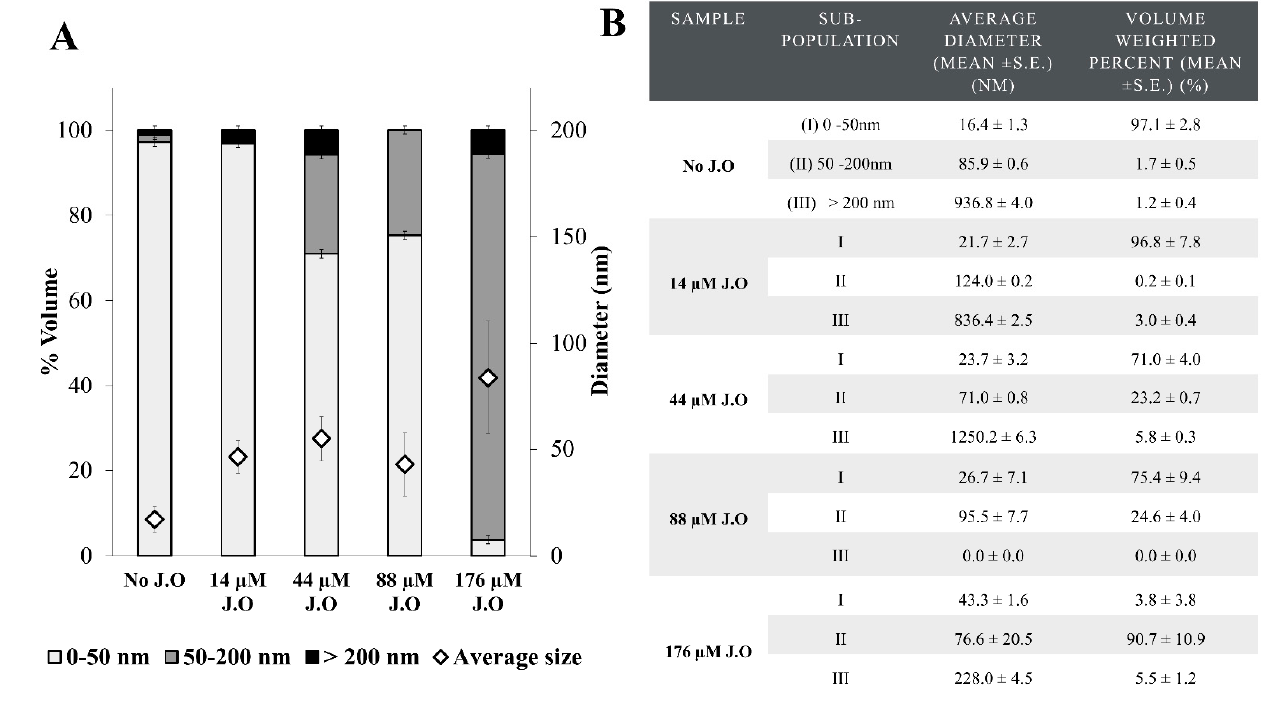
Figure 2. Volume-weighted size distribution of PEG-PCL/PTX NPs with different concentrations of JO determined using dynamic light scattering (DLS). PTX concentration = 14 µ M, PP concentration = 70 µ M. ( A ) Volume-weighted size distribution and average diameters (error bars represent the standard error of the measurements, based on duplicates); ( B ) characterization of subpopulations.